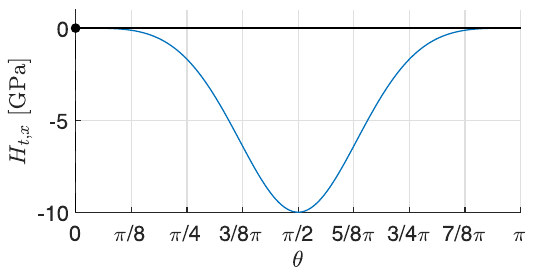
Figure 3. H ( θ ) for uniaxial tension in x -direction